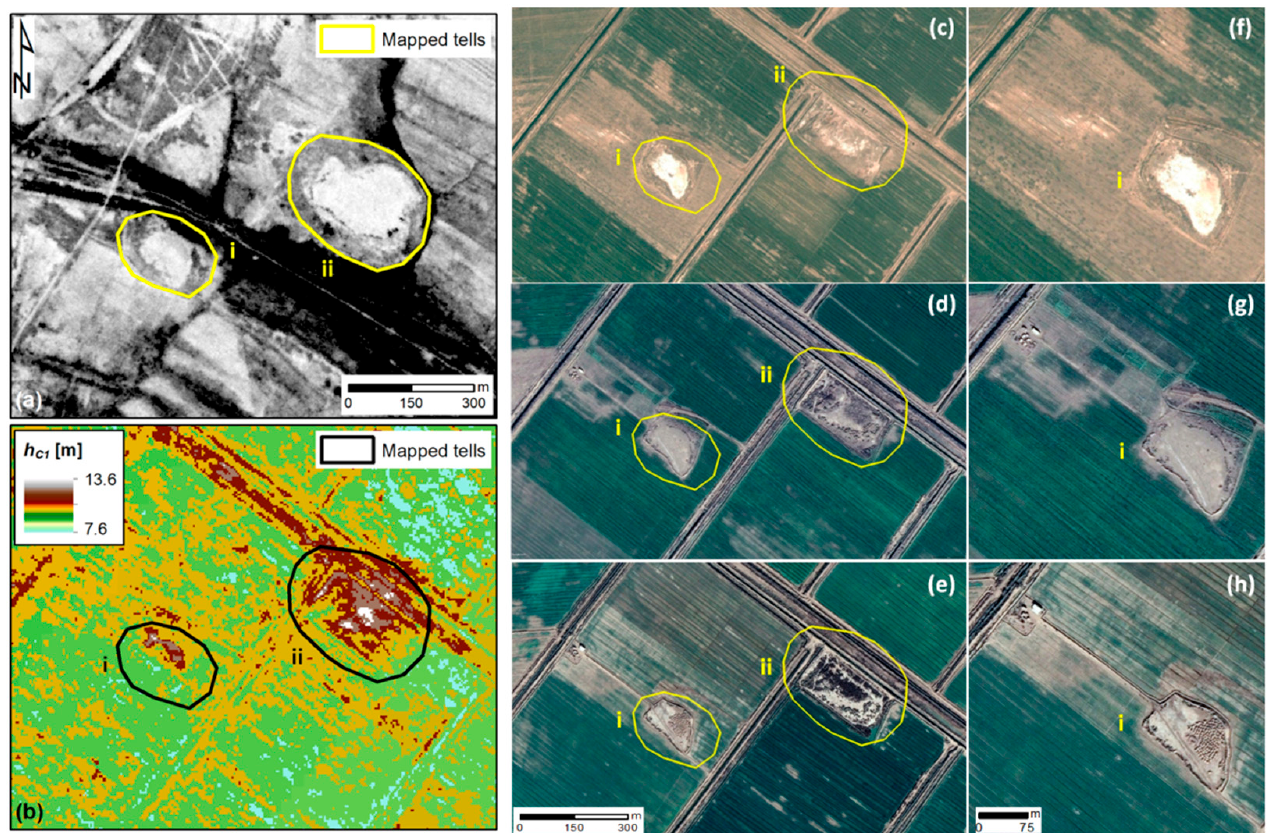
Figure 14. Example of tells (labeled “i” and “ii”; precise location undisclosed for security concerns) affected by ‘change of use’ and ‘modern canals’, respectively, as documented by multi-temporal analysis of: ( a ) CORONA imagery and ( b ) CartoSat-1 DSM (©GAF AG. Includes material ©Antrix, distributed by GAF AG), as well as contextual information from Google Earth images (©2021 Maxar Technologies) collected on: ( c ) 9 April 2002, ( d ) 5 January 2016 and ( e ) 22 December 2020, with ( f – h ) zoomed views highlighting the transformation of tell “i” and its change of use in connection to very recently built farm dwellings.